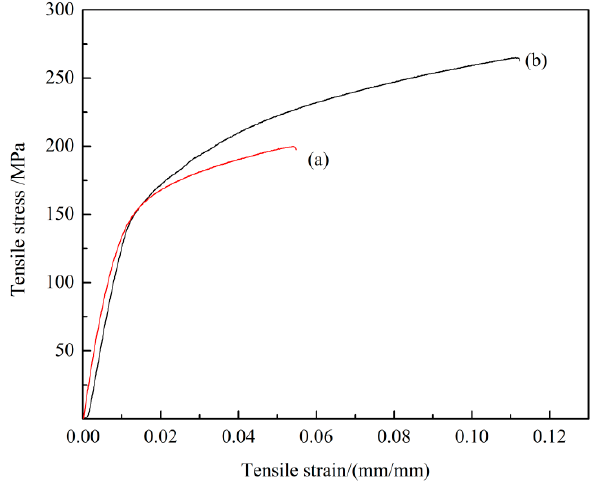
Figure 10. Room-temperature tensile stress-strain curves of the as-cast Mg-3Y-3.5Sm-2Zn-0.6Zr alloy and: ( a ) Without UST; ( b ) with UST.